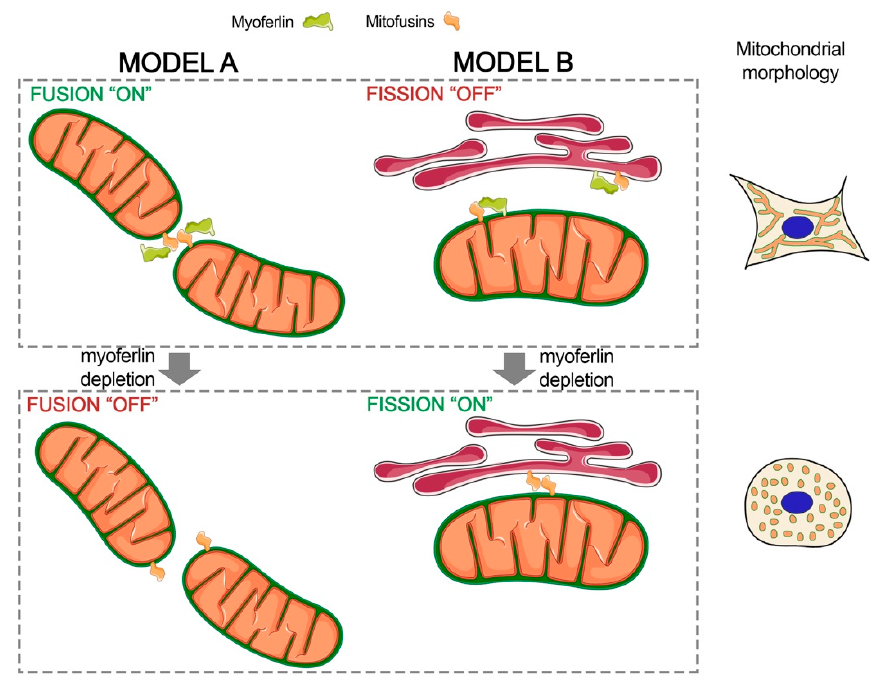
Figure 7. Proposed models for myoferlin involvement in mitochondrial dynamics. Model A describes the functional interaction between mitofusins and myoferlin. Myoferlin interacts with mitofusin and participates, as a positive regulator, to mitochondrial fusion. Myoferlin depletion reduces efficiency or inhibits the mitofusin-mediated mitochondrial fusion. Model B depicts the mitofusin sequestration by myoferlin impairing the ER-mitochondria tethering and subsequent fission. Myoferlin silencing results in the stabilization of the ER-mitochondria tethering by mitofusin interaction allowing ER wrapping and DRP1 recruitment. Designed with Servier Medical Art (https://smart.servier.com) licensed under